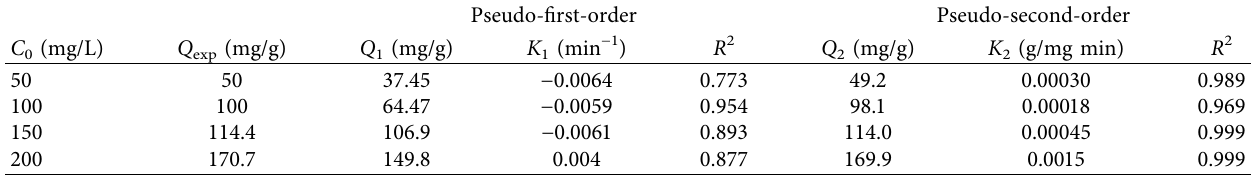
Table 4: Kinetics constants for the adsorption of Murexide.